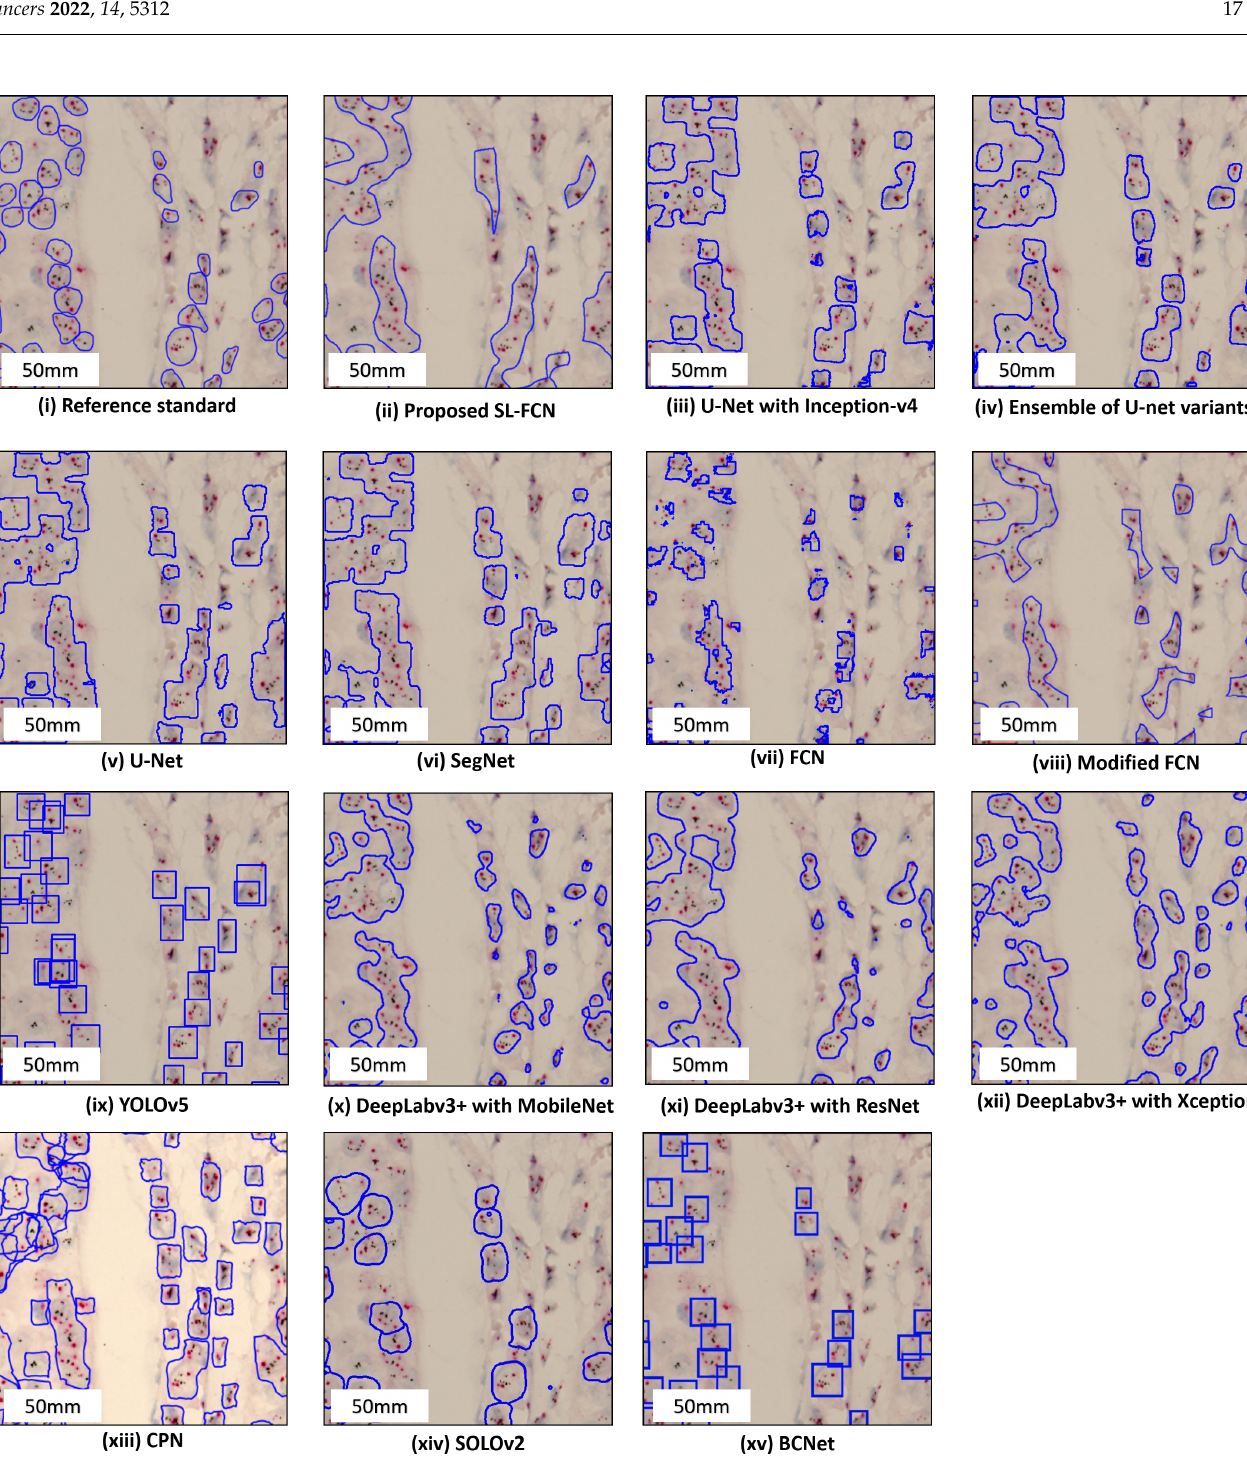
Figure 5. Qualitative segmentation results of the proposed SL-FCN method and the baseline methods for segmentation of HER2 amplification in DISH dataset